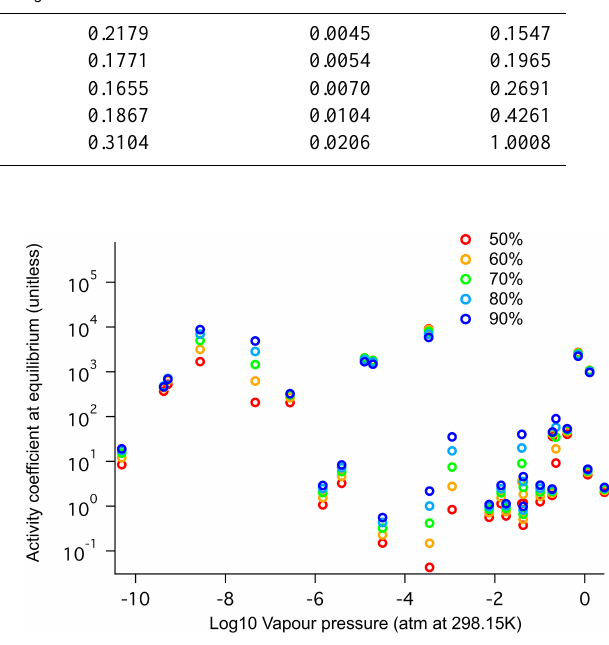
Figure 4. The range of predicted activity coefficients (unitless on a mole fraction scale) for each organic compound as a function of saturation vapour pressure and